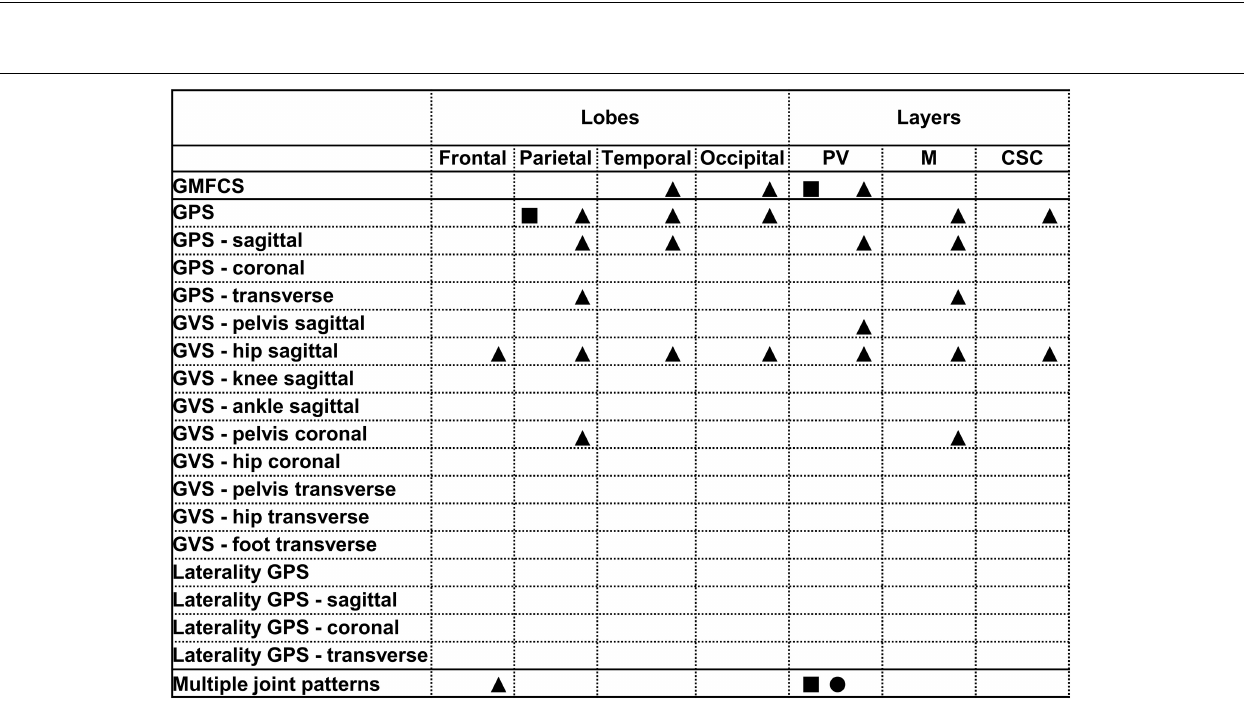
Frontiers in Human Neuroscience |